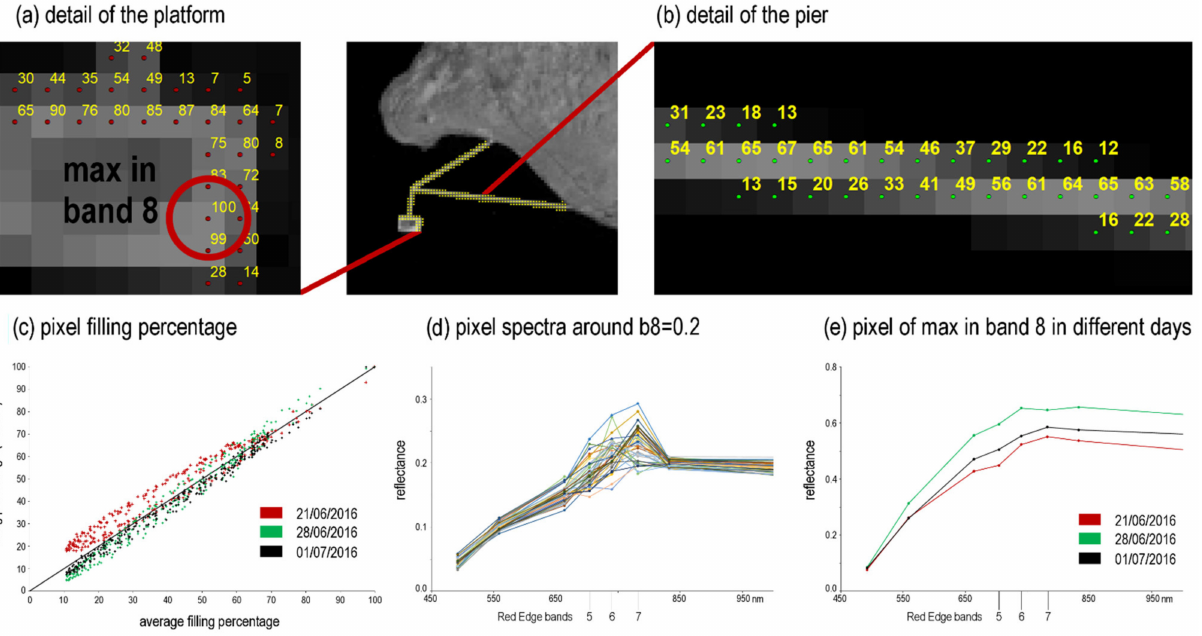
Figure A2. ( a ) Max of band 8 found within the enlarged platform. ( b ) Pixel filling percentages (percent) along the pier. ( c ) Filling percentages of the same pixels in the three dates. ( d ) The ‘wiggling’ effect for pixels comprised in a small range of band 8. ( e ) Spectra of the pixel with max in band 8 in the three Sentinel-2